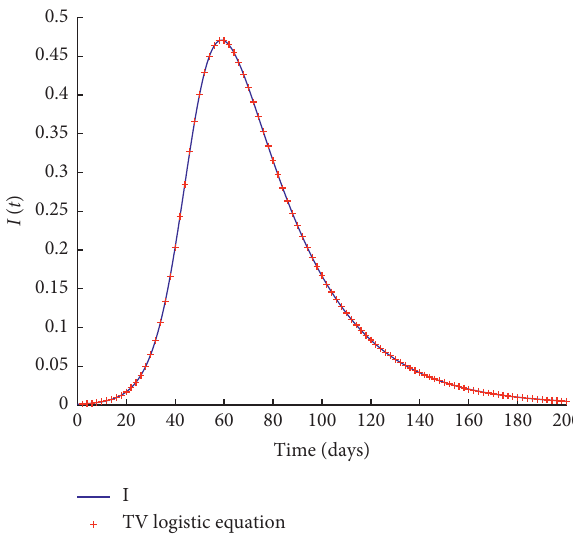
Figure 3: Number of active cases per day obtained from the complete SIR model and from the time-varying logistic equation.